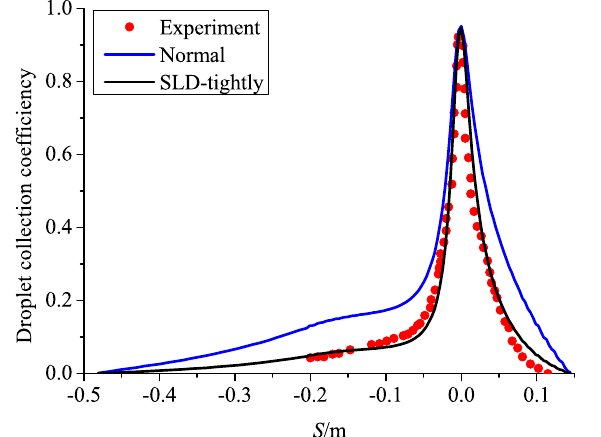
Figure 9. Droplet collection coefficient of the SLD-case. The normal model is the Eulerian method without droplet deformation, breaking, splashing, bouncing and